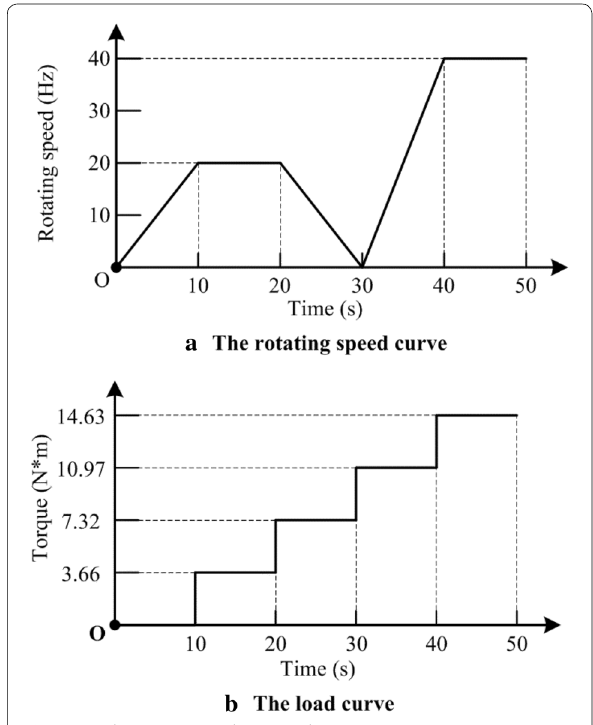
Figure 8 The varying working condition